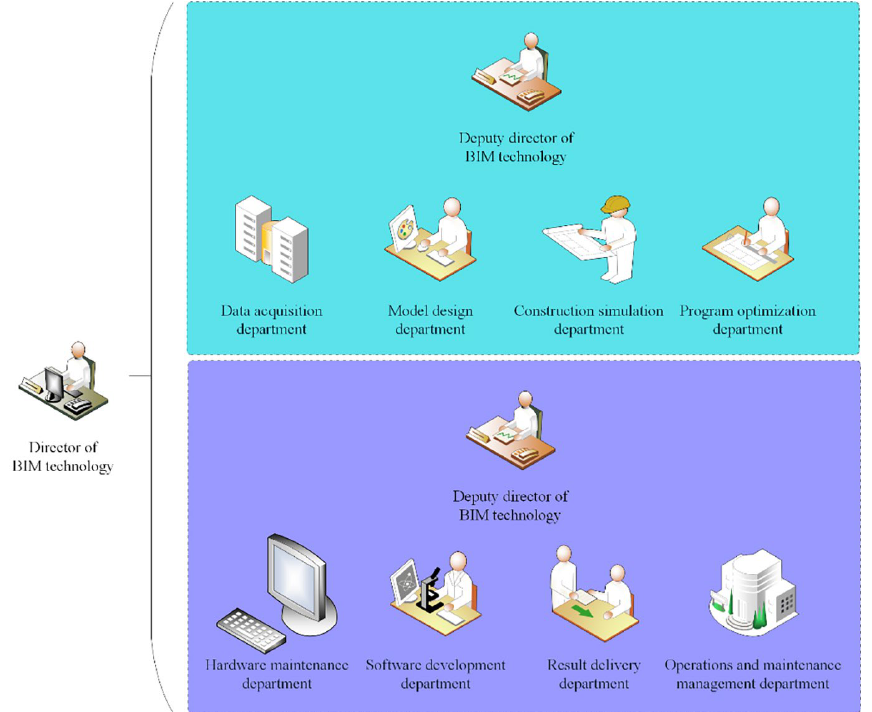
Figure 2. Organization structure diagram of BIM